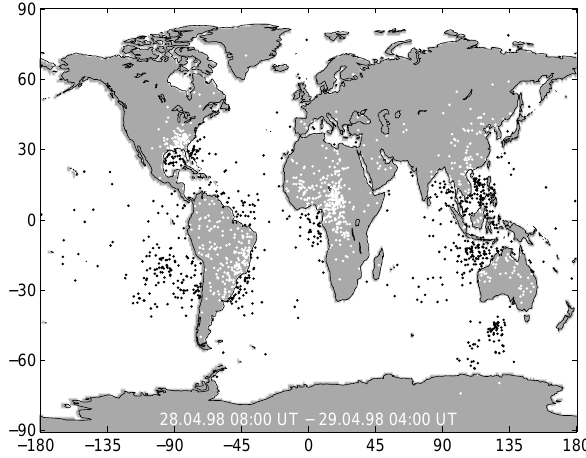
Fig. 2. Particularly intense oceanic (black dots) and continental (white dots) lightning discharges are displayed over the land masses (gray patches) from 28–29 April 1998. Many lightning discharges occur in the coastal areas and over the oceans.